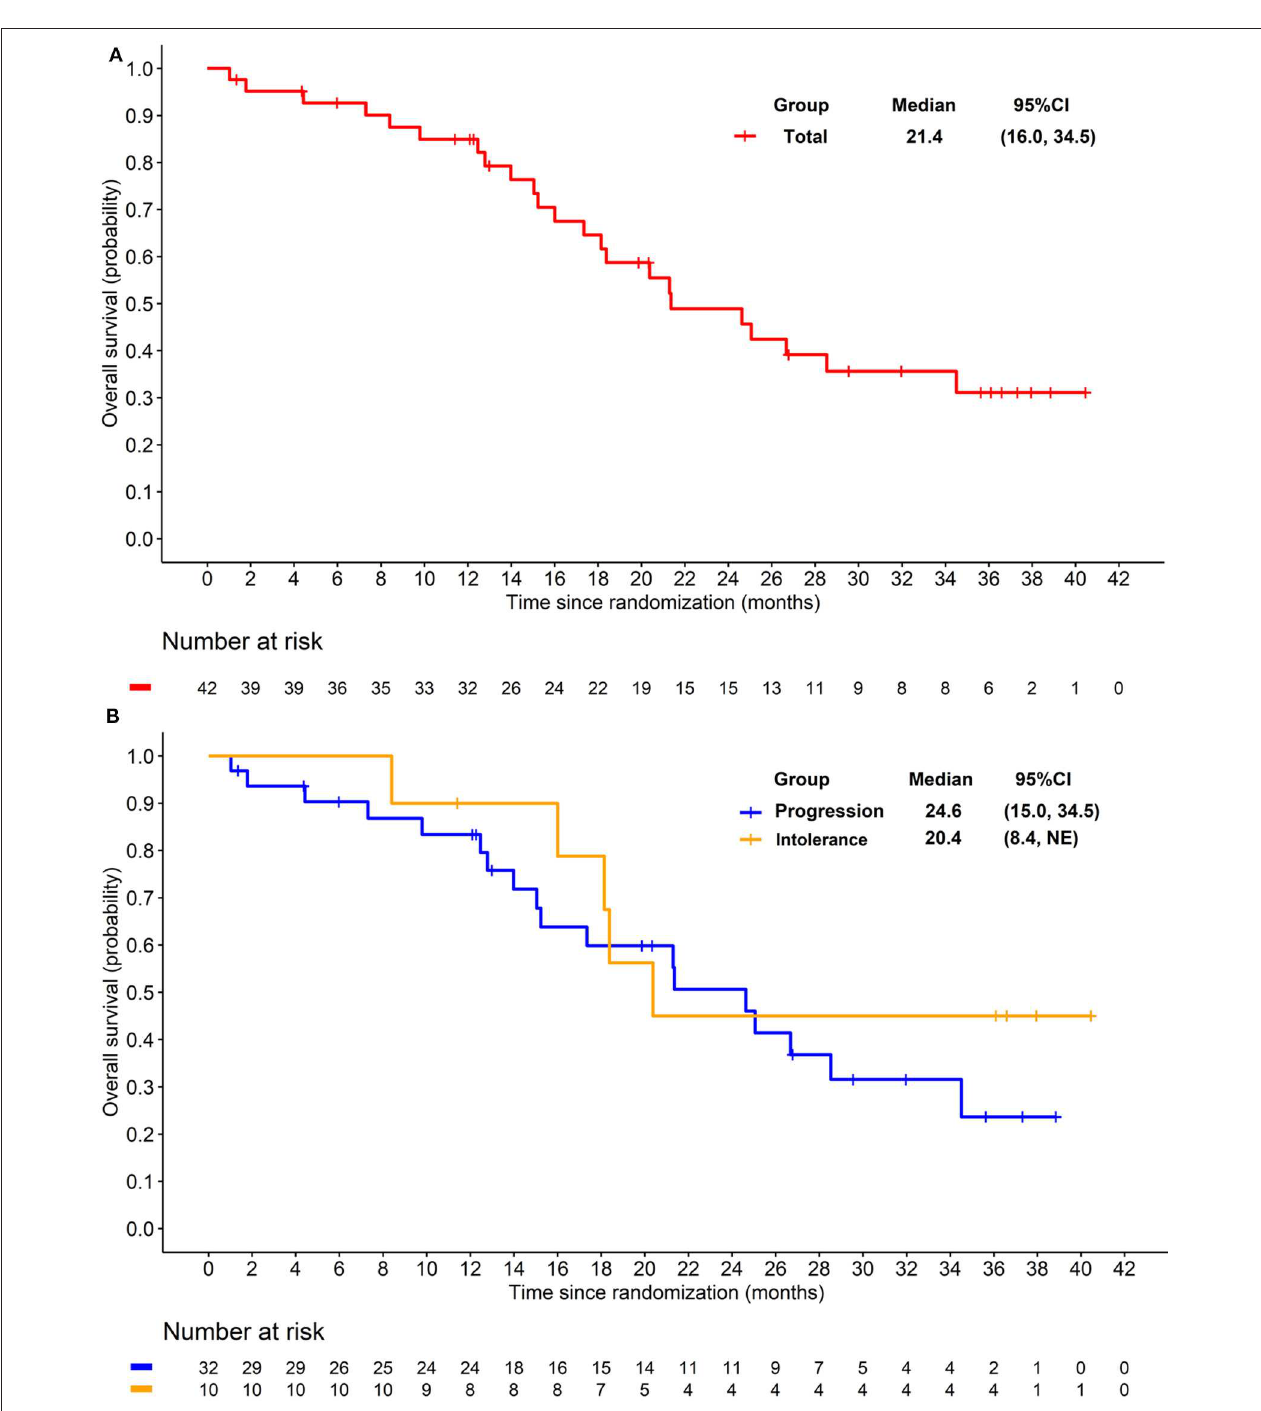
FIGURE 3 | (A) Kaplan-Meier plot of overall survival in overall patients. (B) Kaplan-Meier plot of overall survival in patients progressed from previous TKI treatment (Blue) and intolerant to previous TKI treatment (yellow).